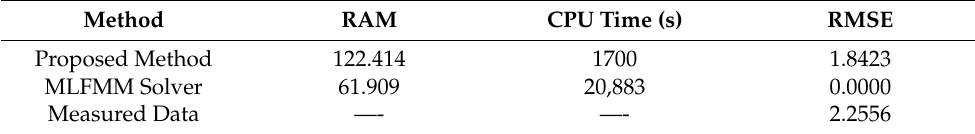
Table 1. The RMSE and CPU time of the different methods. Method RAM CPU Time (s) RMSE Proposed Method 122.414 MLFMM Solver Measured Data 2.2556